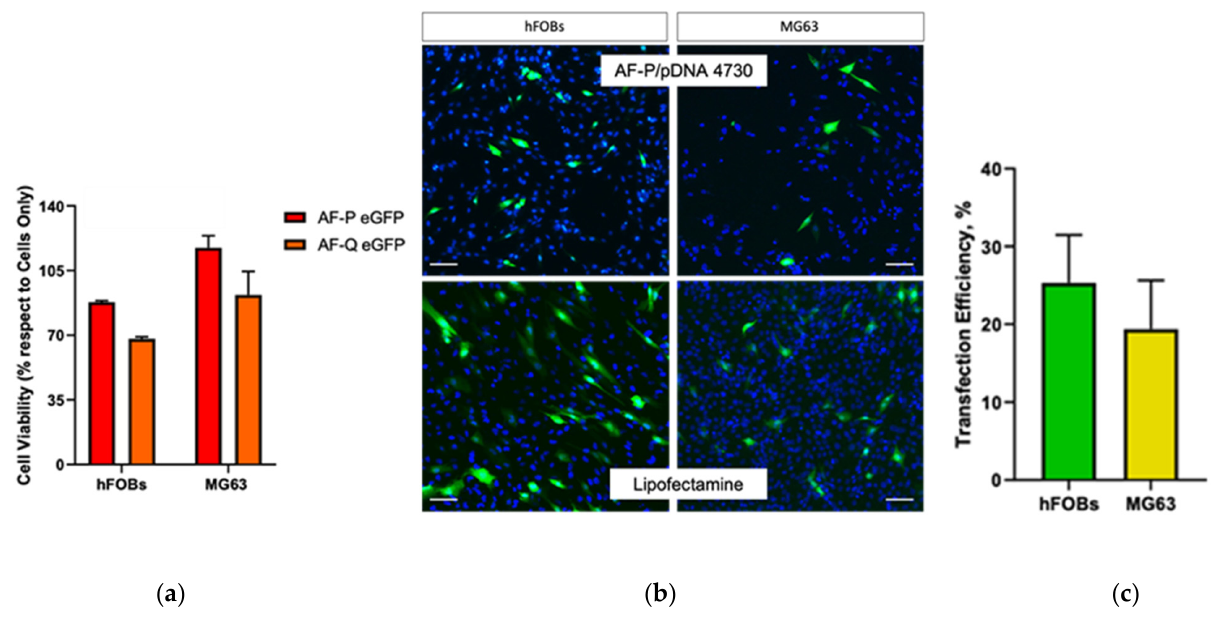
Figure 8. ( a ) Cells viability analysis. MTT assay was performed after 24 h of culture. hFOBs and MG63 were cultured in contact with 20 µg.mL − 1 of AF-P eGFP and AF-Q eGFP at N/P of 8. The data show the percentage of viable cells as compared to cells only, as the control and the mean ±SEM are presented. ( b ) Qualitative transfection efficacy images. eGFP positive cells in green and cell nuclei in blue. Scale bars: 100 µm. ( c ) Transfection efficiency. % of transfection efficiency of AF-P eGFP complex at N/P of 8 compared to Lipofectamine used as control group.